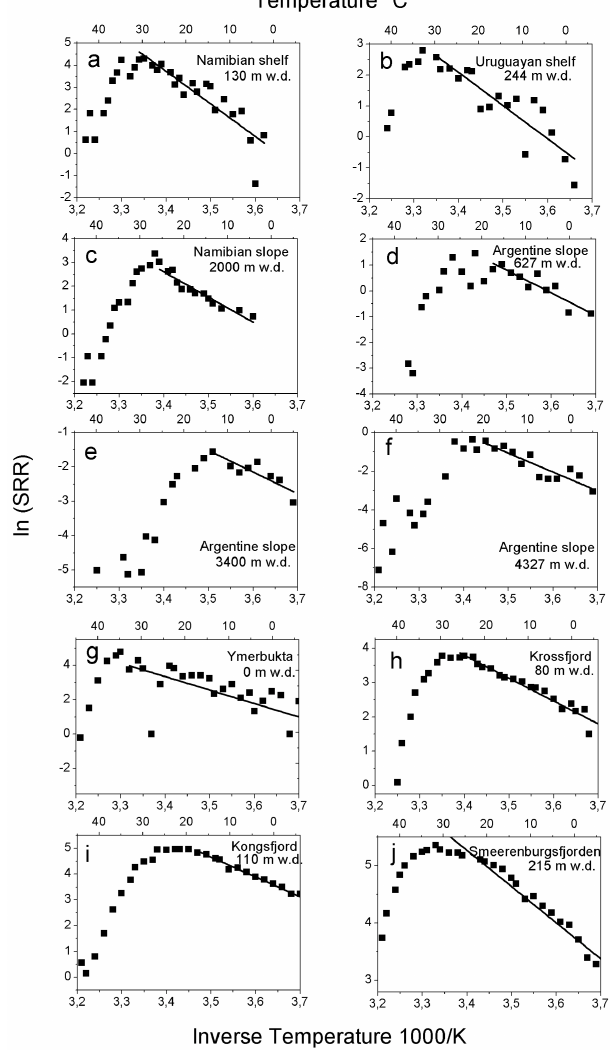
Fig. 2. Arrhenius plots of data in Fig.